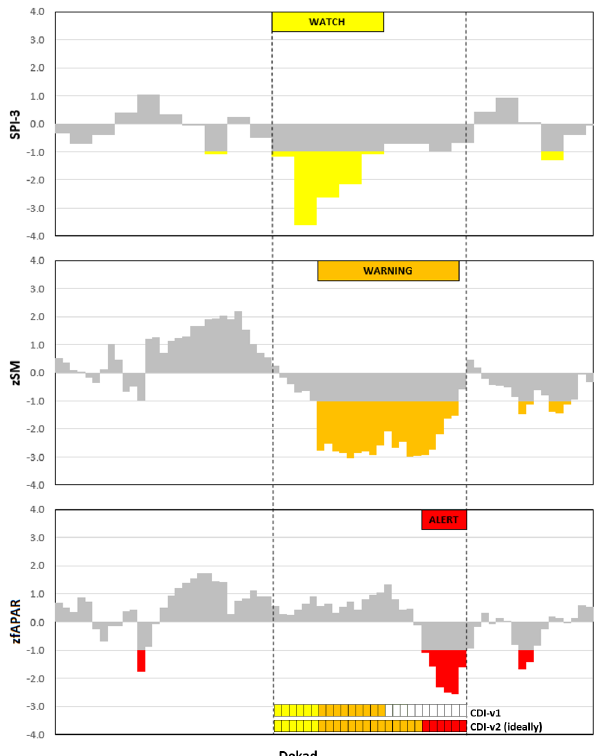
Figure 2. Example of the possible cascade process driving the evo- lution in the case of a drought event in Spain. Dotted lines delimit the period under drought, whereas the squares at the bottom of the plots report the outcome of the operational CDI (CDI-v1, upper line) and the ideal evolution of a revised version’s (CDI-v2 ideally, lower line) values for each dekad.